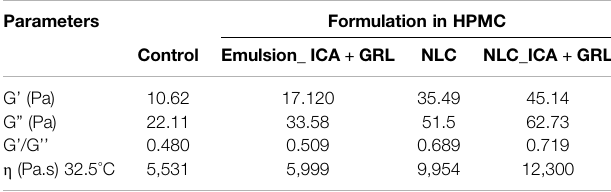
TABLE 2 | Rheological parameters G ’ (elastic modulus), G ” (viscous modulus), and η (viscosity), measured at a frequency of 1 Hz for the control hydrogel (HPMC), the emulsion with 2% GRL and 5% ICA, the NLCs formulation (hydrogel) without active ingredients, and the NCLs formulation (hydrogel) with 2% GRL and 5%